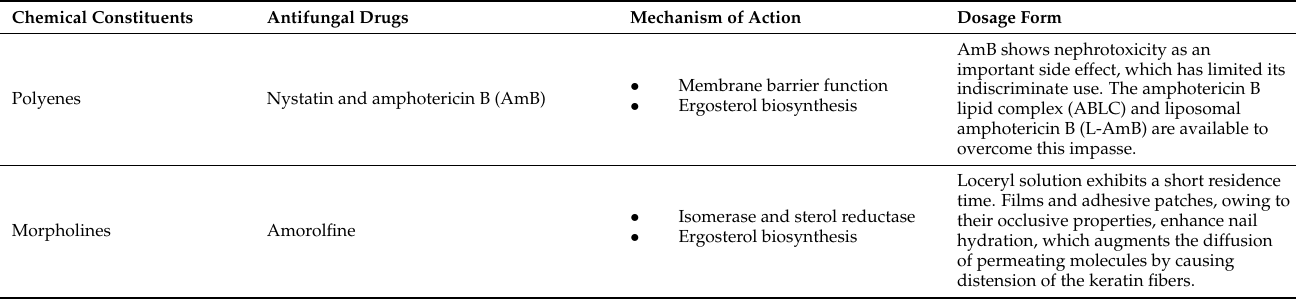
Table 1. Site-specific action of antifungal drugs